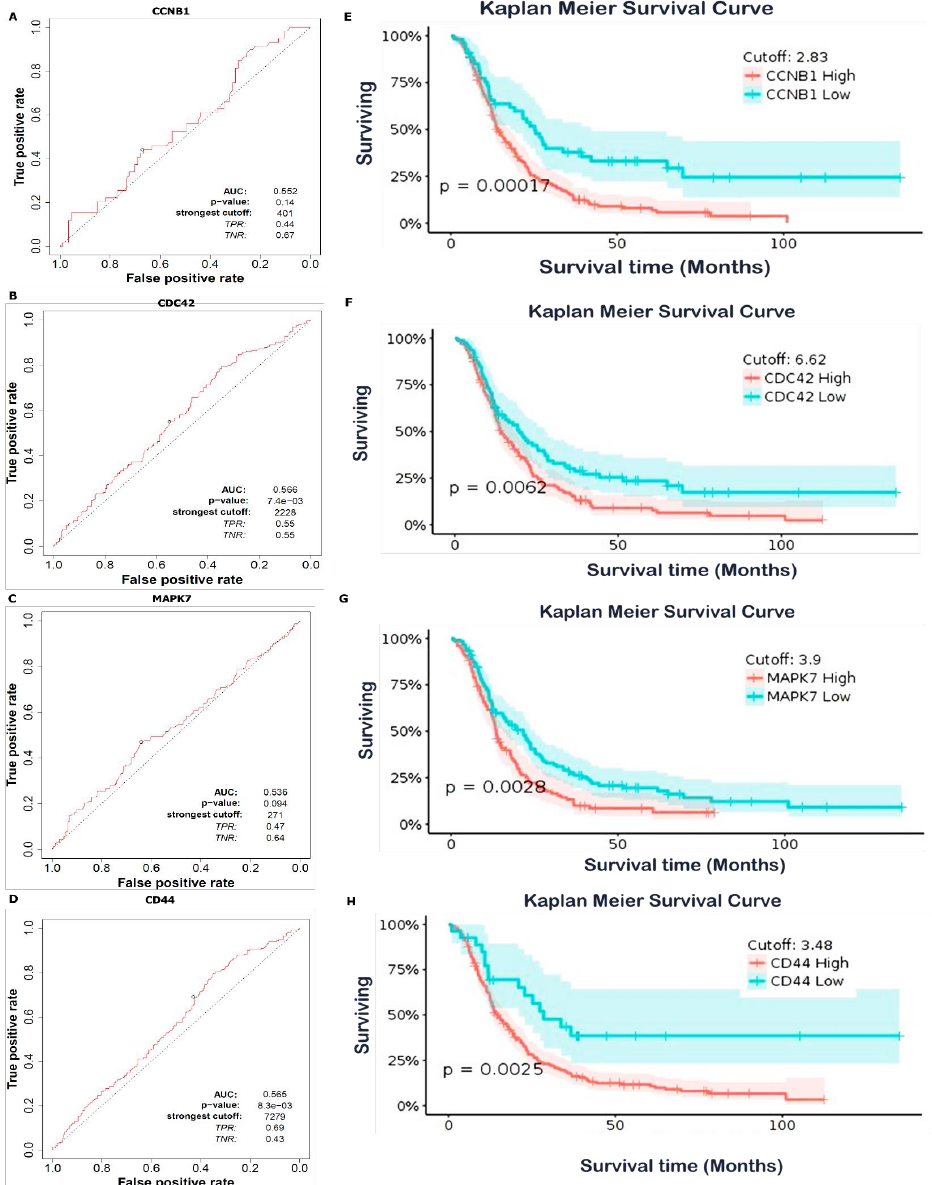
Figure 9. High expression levels of the CCNB1, CDC42, MAPK7, and CD44 oncogenes were associated with a poor prognosis in glioblastoma multiforme (GBM). ( A – D ) Time-dependent ROC analysis according of the true positive (sensitivity) and false positive (specificity) rates of survival, assessed by the prognostic accuracy based on AUC values. CCNB1 (AUC: 0.552) , CDC42 (AUC: 0.566) , MAPK7 (AUC: 0.536), and CD44 (AUC: 0.565). An AUC of 0.5 indicates no discrimination, while an AUC of 1.0 indicates discrimination. ( E – H) Kaplan – Meier analysis predicted a significant prolonged overall survival time in the low-risk group compared to the high-risk group. The analysis was based on the optimal cutoff point from the low- and high-risk groups, and p < 0.05 was considered significant.